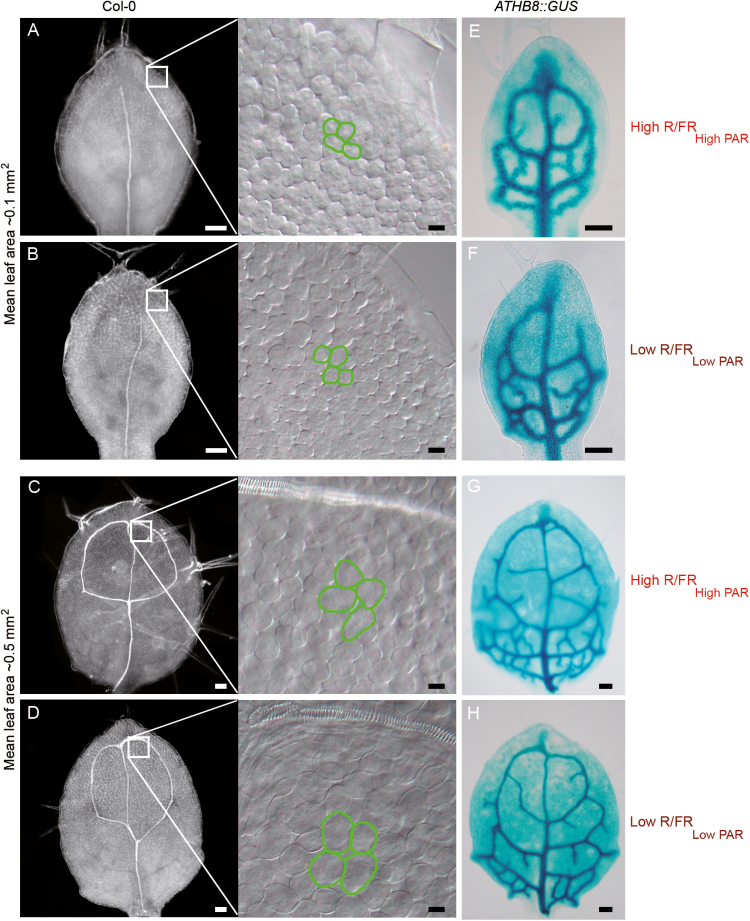
Shade affects adaxial subepidermal cell expansion and vein pattern formation in the leaf. (A–D) Dark-field images of cleared first and second leaves of Col-0 seedlings grown for 7 d (A) and 8.5 d (C) in High R/FRHigh PAR (High R/FRHigh PAR), or for 4 d in High R/FRHigh PAR and subsequently for 4 d (B) and 6 d (D) in Low R/FRLow PAR (Low R/FRLow PAR), respectively. The insets show a paradermal view of adaxial subepidermal cells; the borders of a few cells have been highlighted manually with a green line. (E–H) Histochemical localization of GUS activity in the first and second leaves of ATHB8::GUS seedlings grown as in (A–D). First and second leaf area (mean ±SE): (A) 0.10 ± 0.005 mm2; (B) 0.09 ± 0.003 mm2; (C) 0.52 ± 0.007 mm2; (D) 0.50 ± 0.003 mm2; (E) 0.09 ± 0.004 mm2; (F) 0.10 ± 0.003 mm2; (G) 0.51 ± 0.022 mm2; (H) 0.50 ± 0.024 mm2. Scale bars: (A–H) 100 μm; insets, 10 μm.